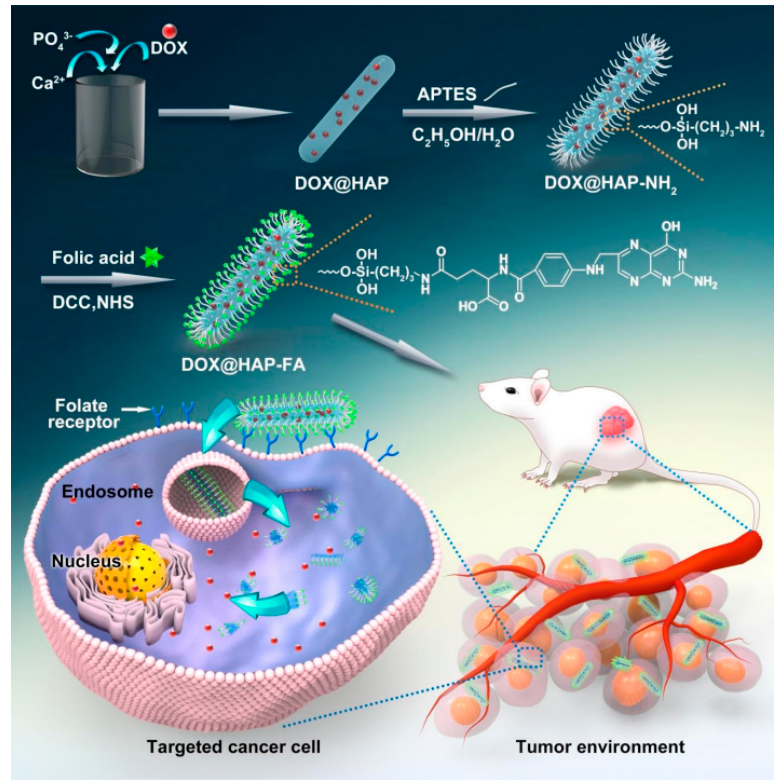
Figure 4. Synthesis route of DOX@HAP-FA nanocarrier and the antitumor mechanism of DOX@HAP-FA in cancer cells. Reprinted with permission from Ref. [34]. Copyright (2018) American Chemical